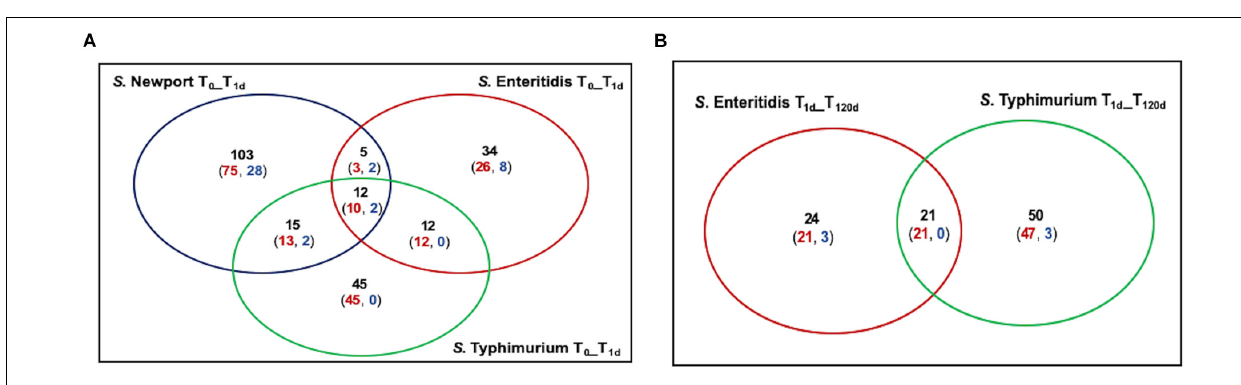
FIGURE 3 | Summary of mutants under selection among the three Salmonella serovars. Insertion sites with significant ( P < 0.05) differences by at least two-fold in relative abundance are shown in panel (A) after drying (T 1d ) compared to immediately after inoculation (T 0 ), and (B) at 120 days of storage (T 120d ) compared to T 1d . Black font indicate numbers of distinct Tn 5 insertion sites with significant ( P < 0.05) change by at least two-fold. Red and blue indicate mutants with a reduction and an increase in relative abundance,